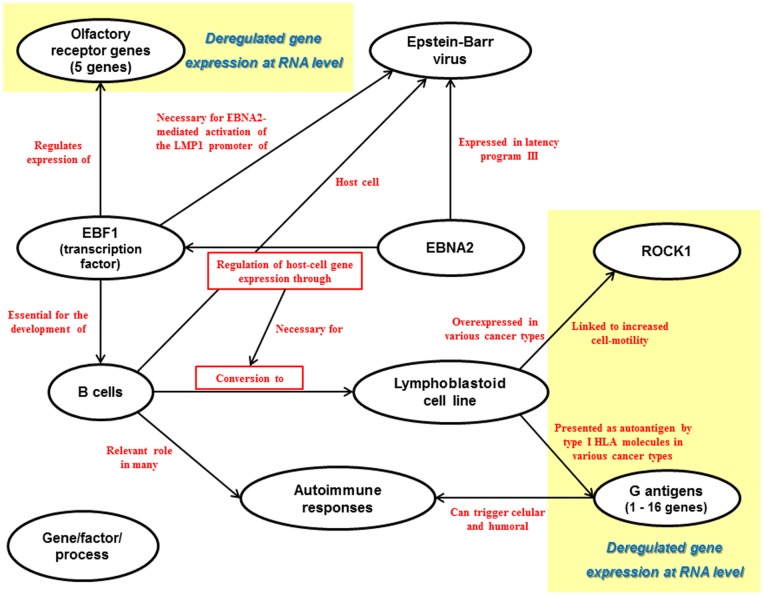
Functional relations between some of the genes of the male module and processes, cells and events known to be involved in multiple sclerosis as described by literature.